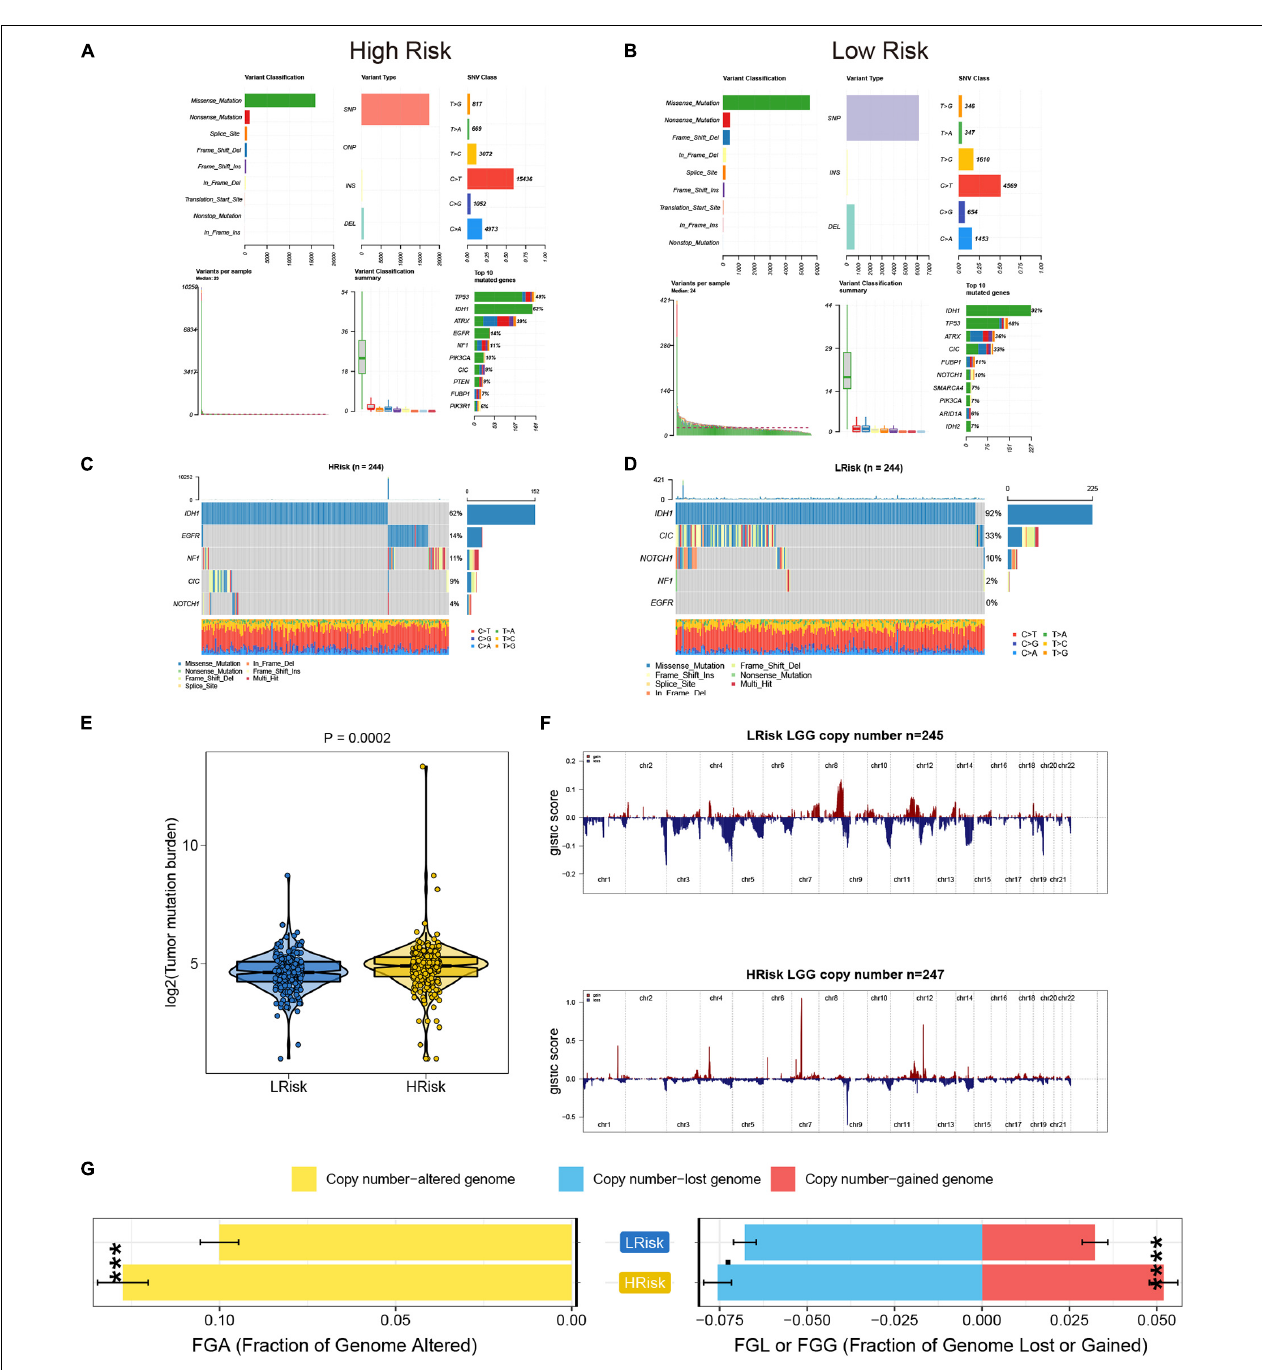
FIGURE 4 | The analysis of TMB and CNVs in the high- and low-risk groups in the TCGA cohort. (A,B) Basic information on somatic mutations in glioma patients in the high- and low-risk groups. (C,D) The waterfall plot of the mutation profile of a single gene in each glioma sample. (E) The differences of TMB in the high- and low-risk groups. (F) The amplification and deletion of gene fragments in glioma patients among the two groups. (G) The comparison of copy number of the altered genome, lost genome, and gained genome between the high- and low- risk groups. *** p < 0.001, **** p <